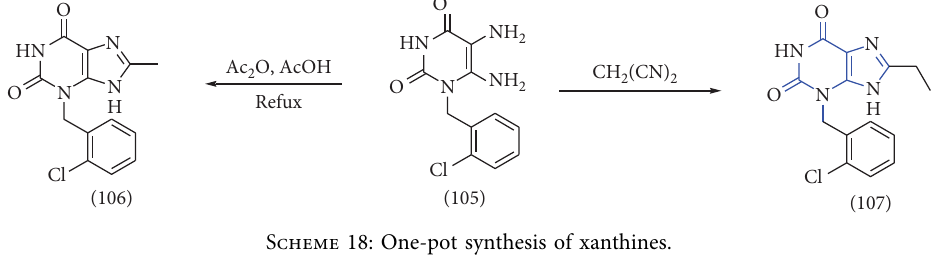
Scheme 18: One-pot synthesis of